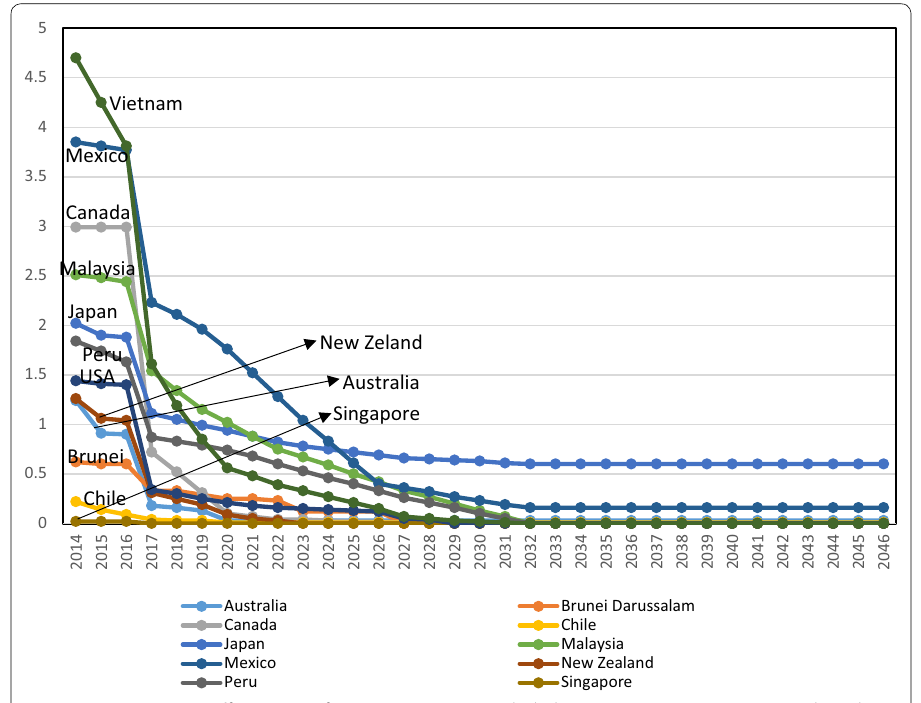
Fig. 1 Average intra-tariff (percent) of TPP countries (USA included) over time (2014–2046). Source : based on data from ITC Market Access Map database (available at